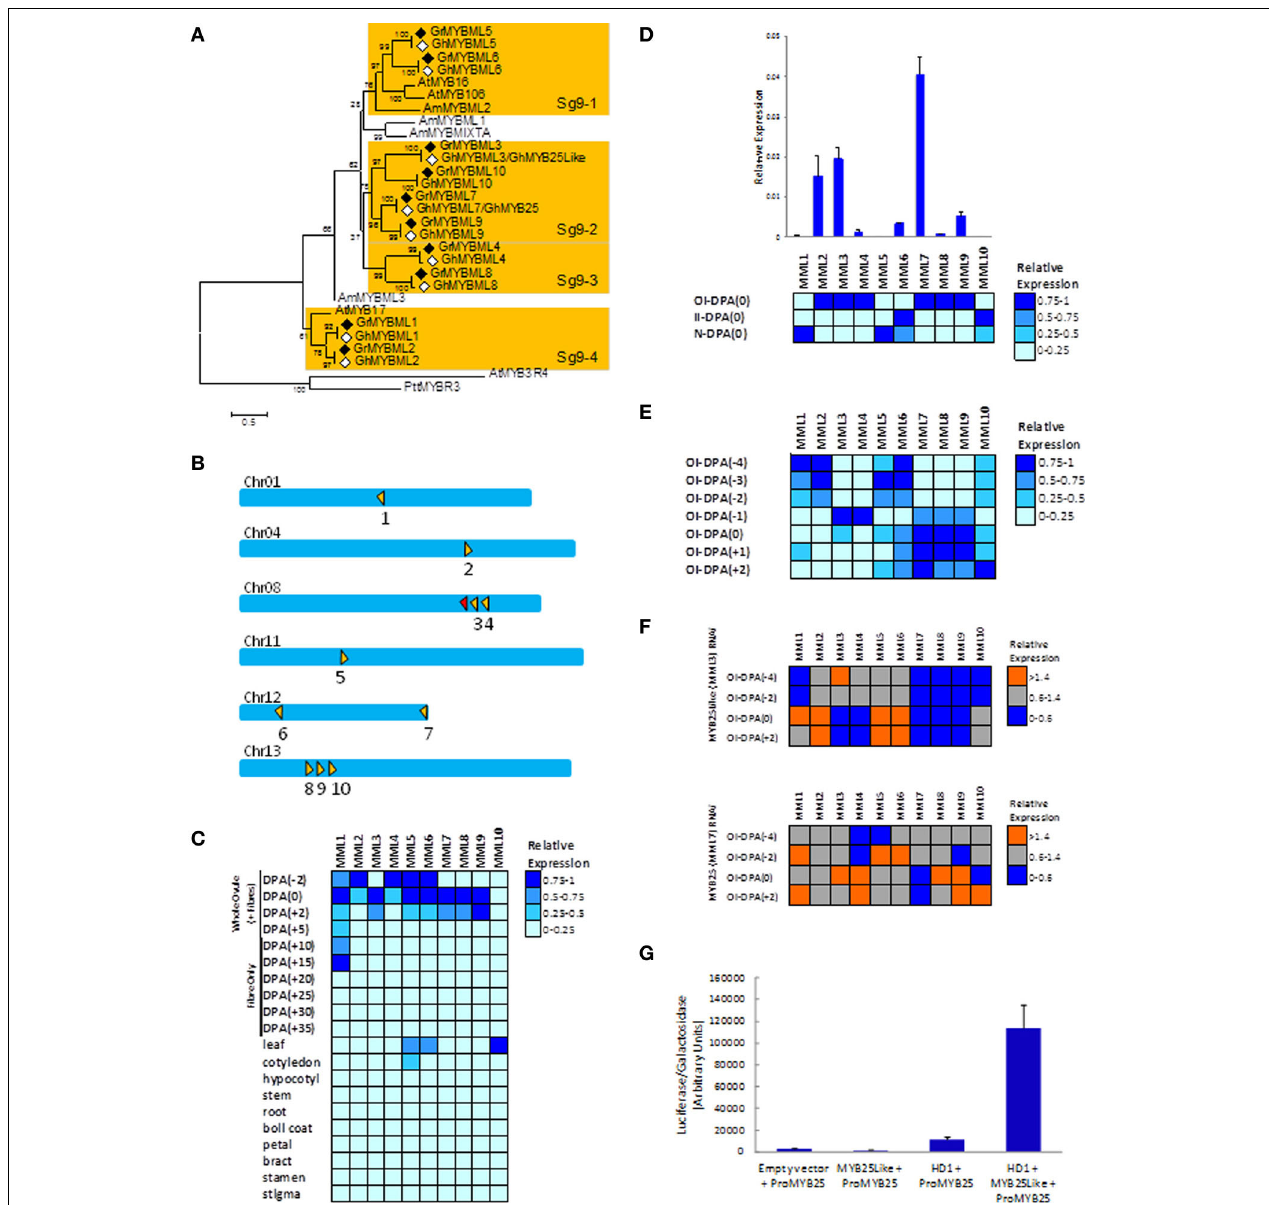
FIGURE 1 | Phylogenetic analysis, chromosomal location, gene expression of the cotton MML genes in wild type and transgenic G. hirsutum , and transactivation of the GhMML3 promoter in cotton protoplasts. (A) Phylogenetic analysis of the G. raimondii (Gr, filled diamonds) MML proteins and their putative G. hirsutum (Gh, empty diamonds) D-genome homologs. Four clades (Sg9-1 to 4) are indicated by shading. The rooted Neighbour–Joining tree was obtained in MEGA 5.0 with Clustal W alignment using the full length amino acid sequences (details in Supplementary data 1 ). Arabidopsis thaliana (At) MYB3R4 and Populus tremula × P. Tremuloides (Ptt) MYBR3 are R1R2R3-MYBs used as outgroups and the other AtMYB and Anthirrinum majus (Am) sequences are landmarks of Subgroup 9. (B) Schematic of the chromosomal distribution of the 10 GrMML genes indicated by the filled triangles, while the unfilled triangle represents a fragment of a MML gene. The directions of the triangle indicate the coding strand of the transcripts and the numbers under the triangle the particular GrMML gene. Adjacent triangles are tandemly arranged genes.